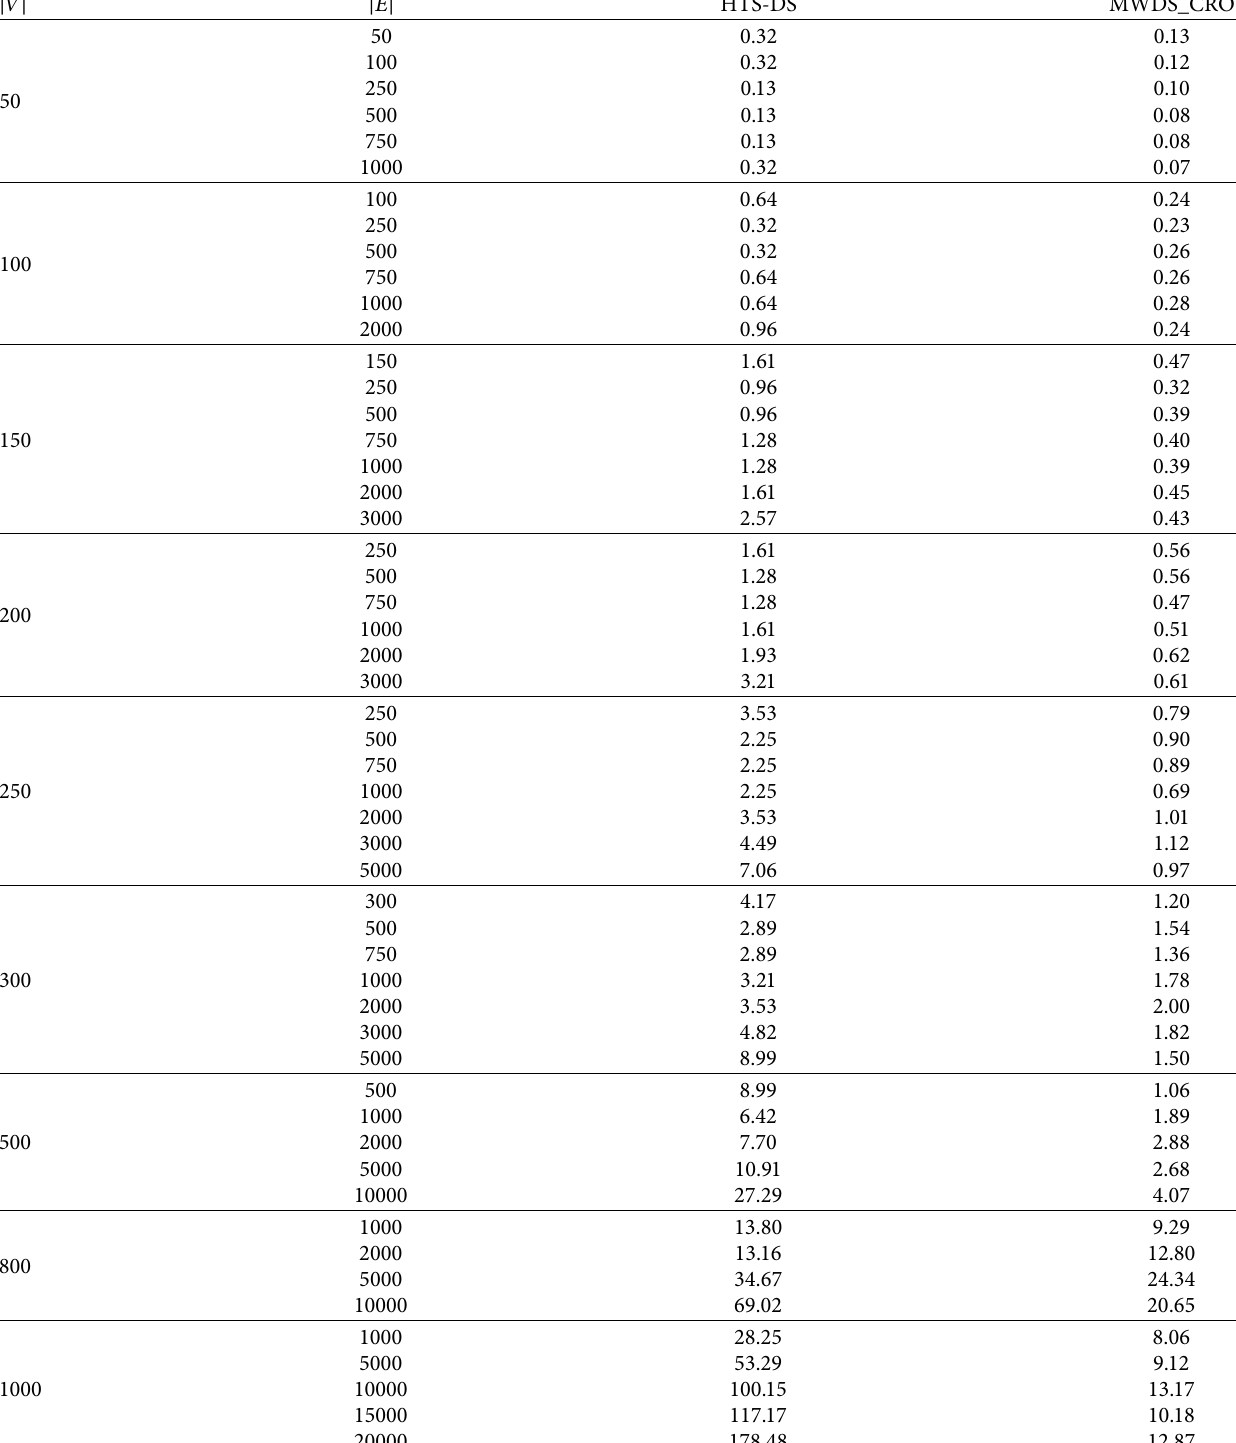
Table 9: Type TII-run time comparison in second of MWDS_CRO with the recent state-of-the-art algorithm.